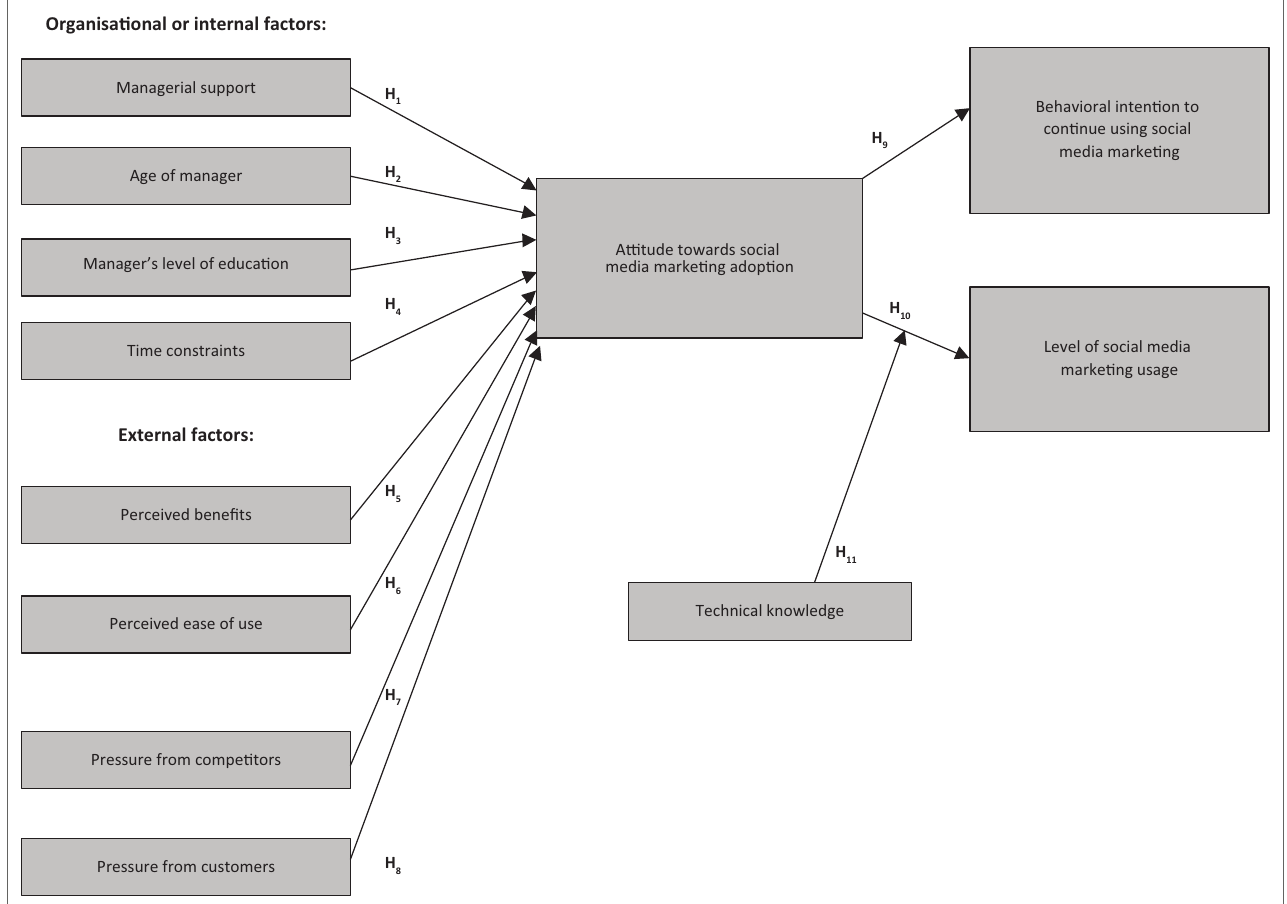
FIGURE 3: Proposed framework.